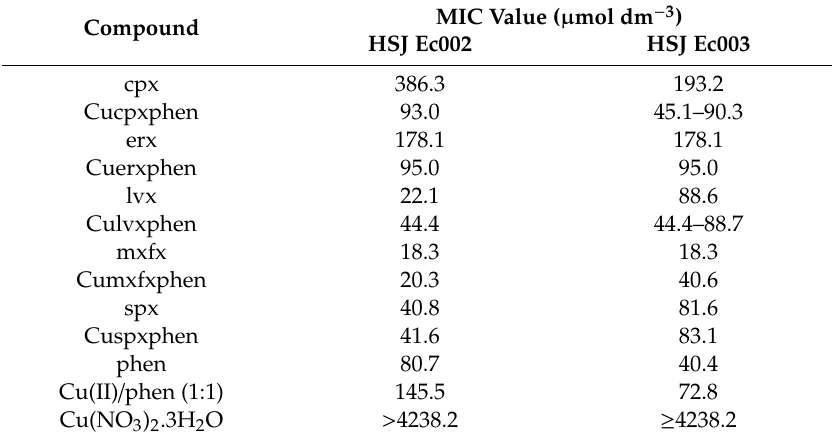
Table 2. MIC values of several FQs, CuFQphen complexes, phen, Cu(II) / phen (1:1) and Cu(NO 3 ) 2 .3H 2 O salt against two MDR isolates of E. coli (HSJ Ec002 and HSJ Ec003). Values presented were obtained from at least three independent experiments.